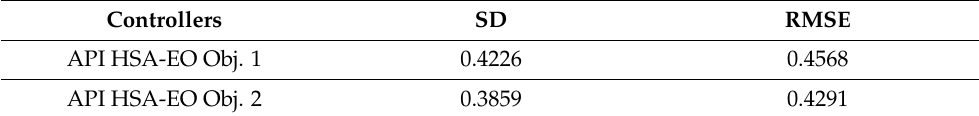
Table 18. Statistical analysis of the active power—faulty fourth